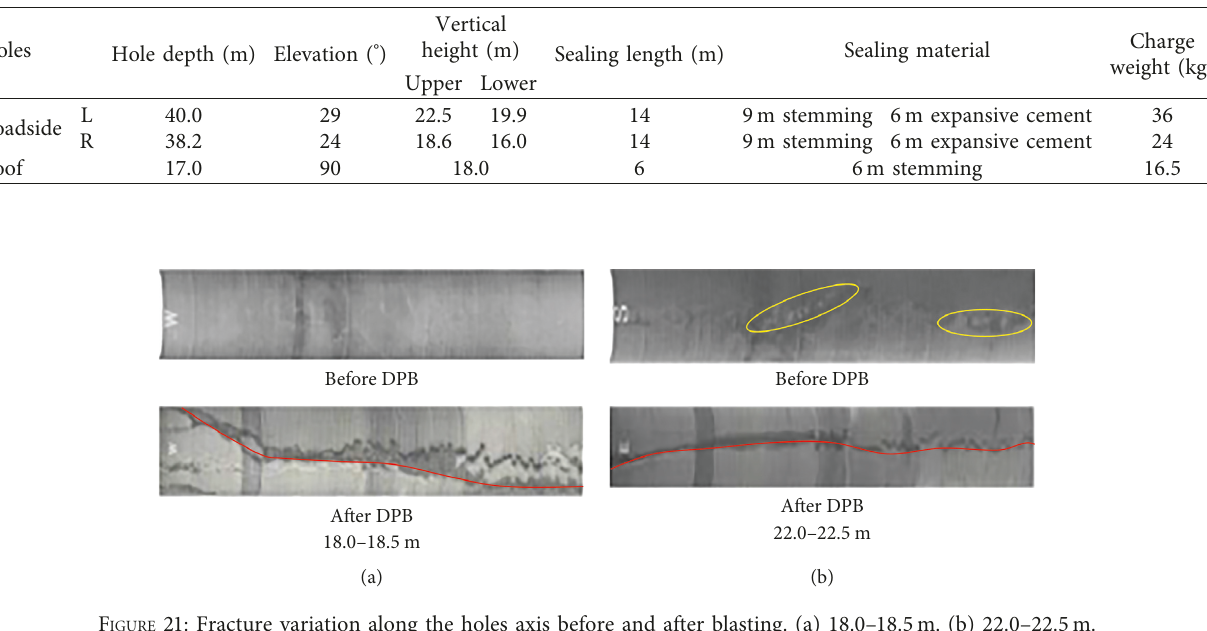
Table 5: Charge parameters of blast holes.